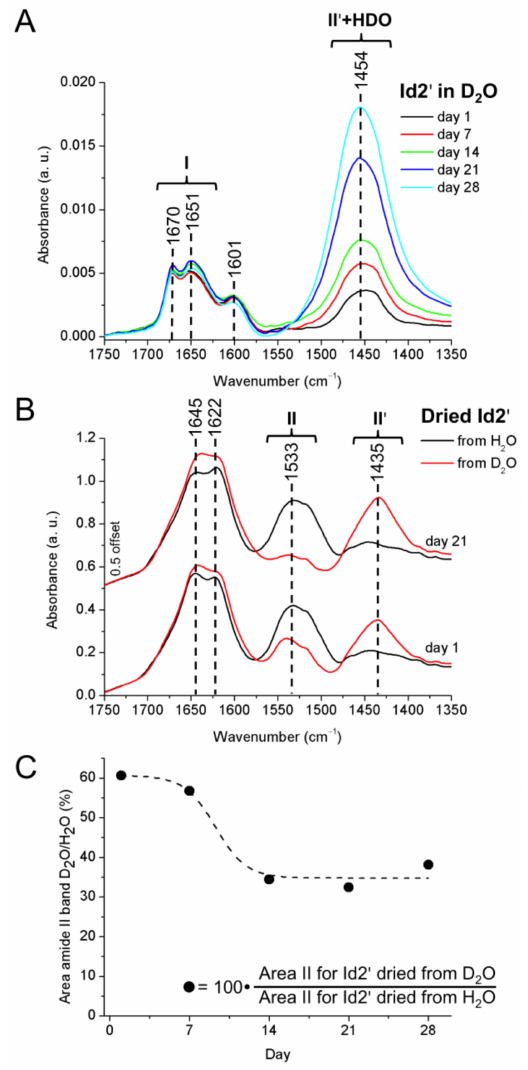
Figure 6. Attenuated total reflection (ATR)-FTIR spectra of Id2’ upon aging. ( A ) Spectra of a 1 mM protein solution in D 2 O recorded over a period of 28 days (sample storage at 5 ◦ C). ( B ) Spectra of Id2’ films obtained upon concentration to dryness under a slow nitrogen stream for 2.5 h of 100 µ L of a 1 mM Id2’ solution in D 2 O or H 2 O. ( C ) Impact of aging on amide hydrogen isotope exchange. The extent of deuterium-to-hydrogen exchange was estimated from the amide II band areas in the spectra of Id2’ films dried from D 2 O and H 2 O,